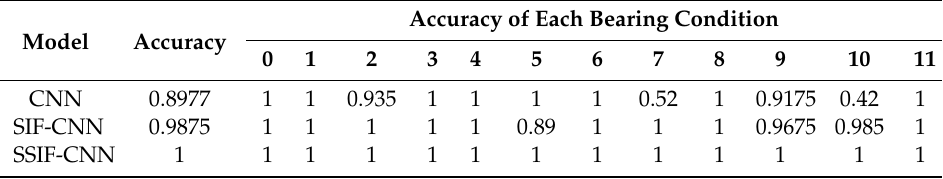
Table 6. The classification accuracy of the training samples.